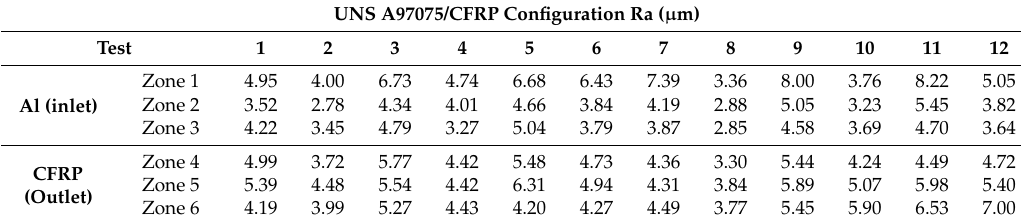
Table A3. Average roughness UNS A97075/CFRP configuration.